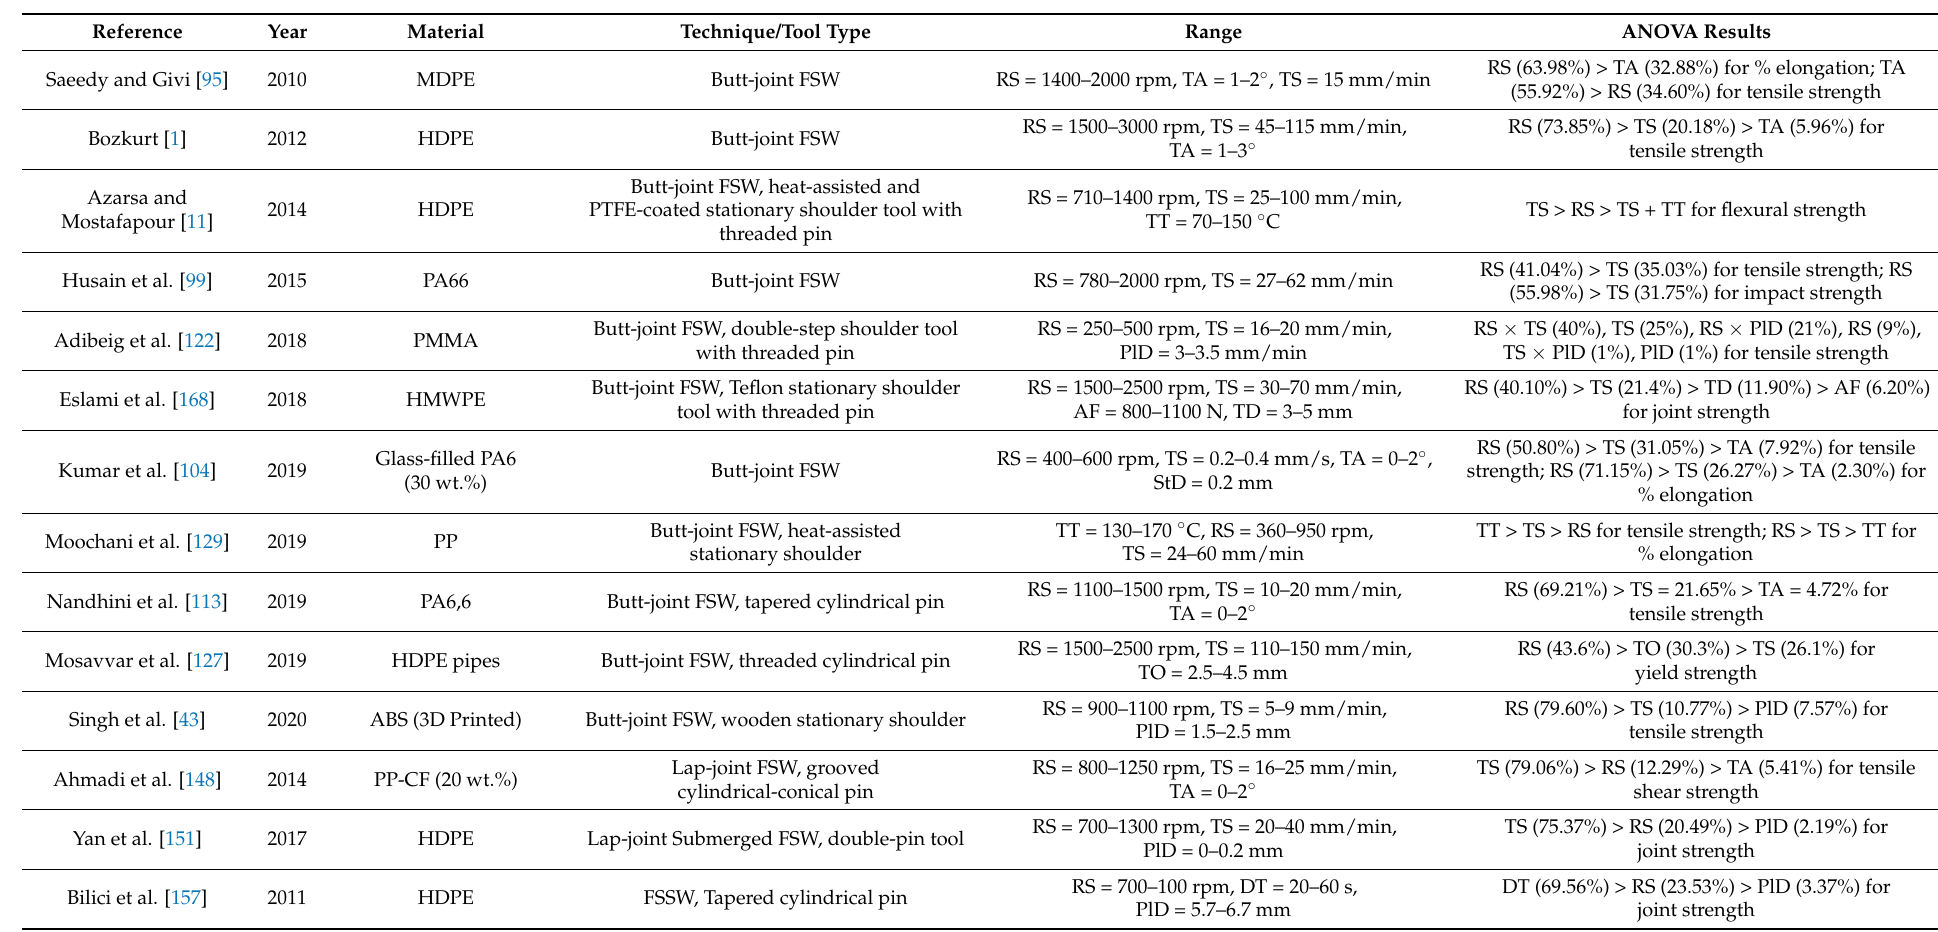
Table 8. Analysis of variance (ANOVA)-based studies of friction stir welding of thermoplastic polymer and polymer composite